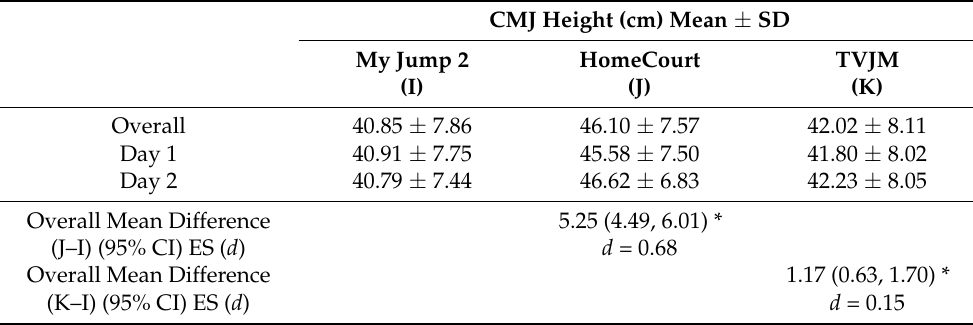
Table 1. Summary statistics of jump heights across three devices in active college students.